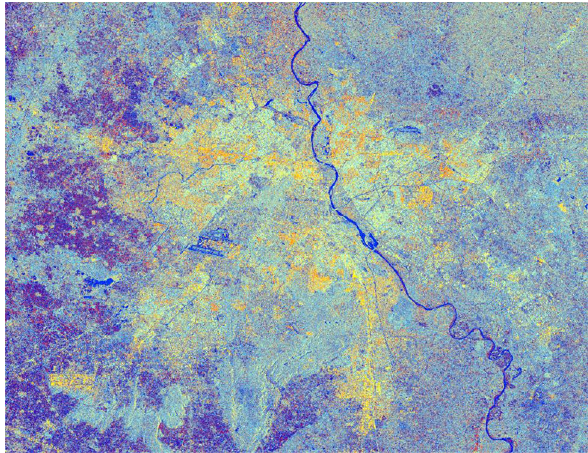
Figure 15. Colour composite image (Red: VV, Green: VH, Blue: VH/VV) of the Sentinel-1 dual-polarization C-band data in with a window size of 7 and sigma value of 0.5.